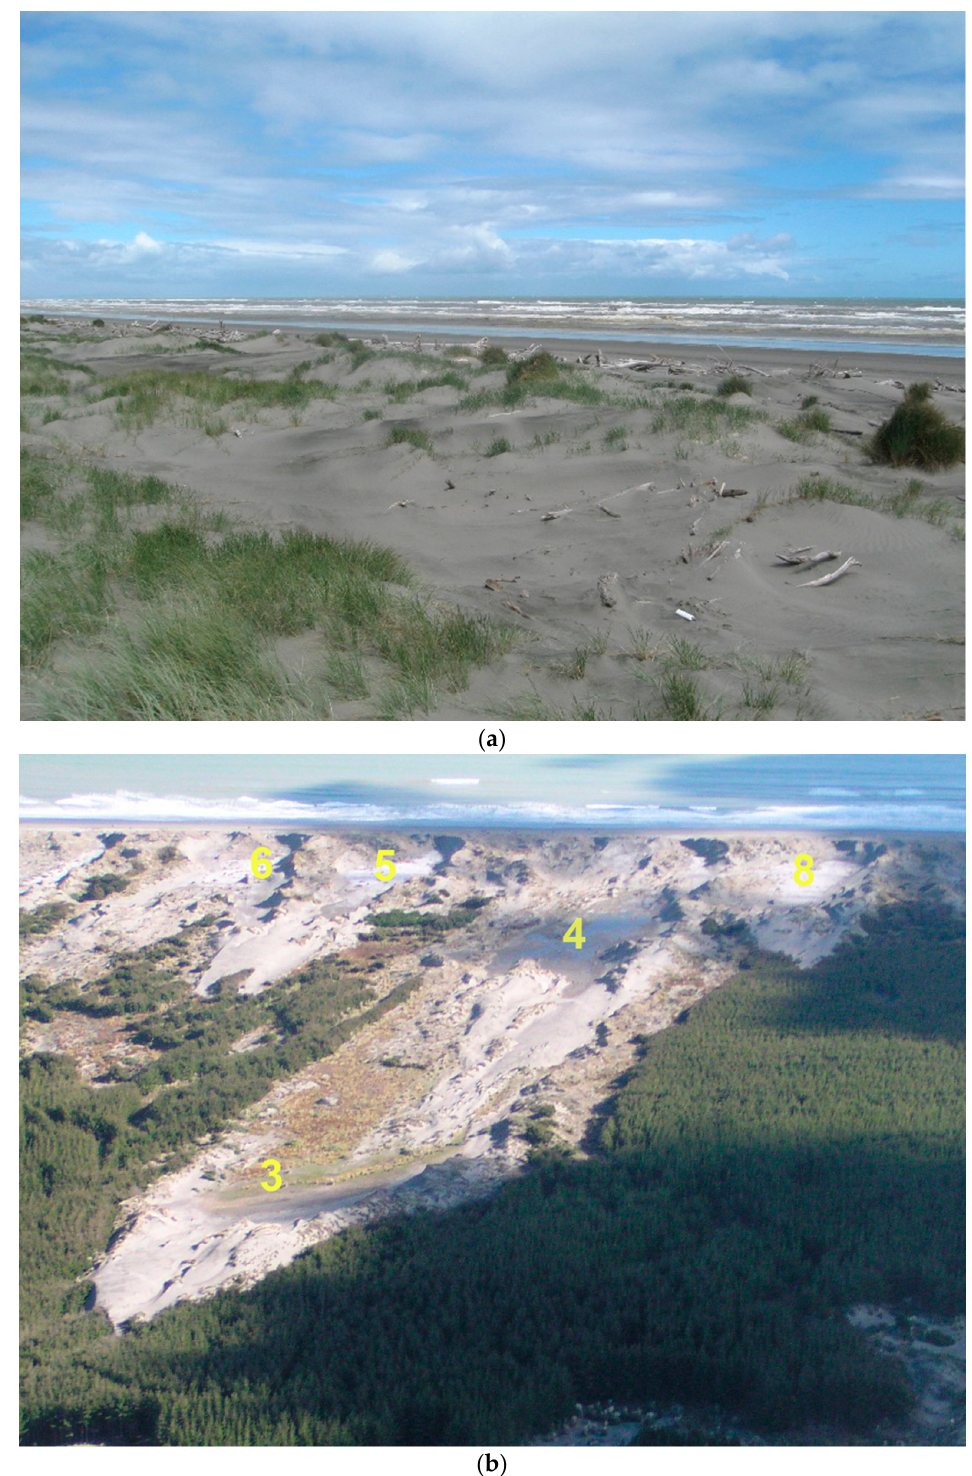
Figure 3. ( a ) New foredune forming in front of the existing foredune, southern Tangimoana, 5 March 2012. The bluish-green is the native foredune-binder Spinifex sericeus , and the dull-green tufts are alien Ammophila arenaria , all plants being self-introduced. Image: G. Rapson. ( b ) Oblique aerial from August 2004 of wetlands at Himatangi (H) embedded amongst pine plantation to 10 m tall (dark green). The wetland numbers are as per Villacís Lozada and Rapson [63]. Note the presence of wetlands H3 and H4 in the same parabola, separated by a transgressive dune. Image: Roger Shand.